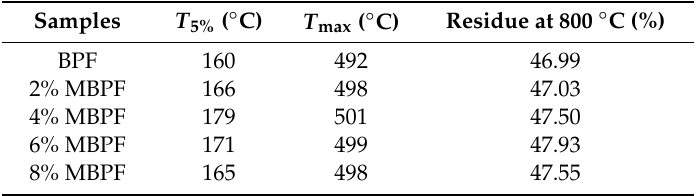
Table 4. The onset temperature of decomposition ( T 5% ), the temperature of fastest decomposition ( T max ), and the residual mass at 800 ◦ C for BPF and